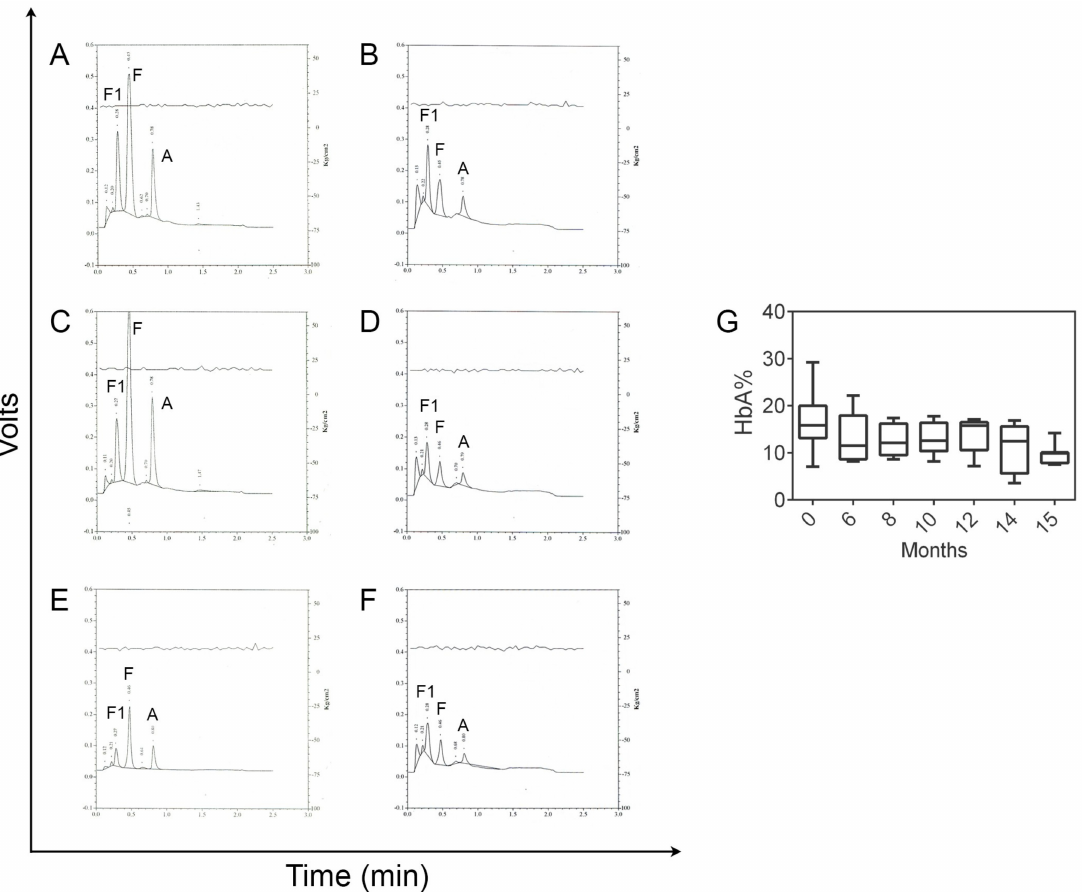
Figure 3. Representative chromatograms of a dried blood spot analyzed within 7 days from blood withdrawal ( A , C , E ) and after four ( B ), eight ( D ) and sixteen months ( F ). Percentages of HbA analyzed after different months from the blood withdrawal ( G ). At least five samples for group were